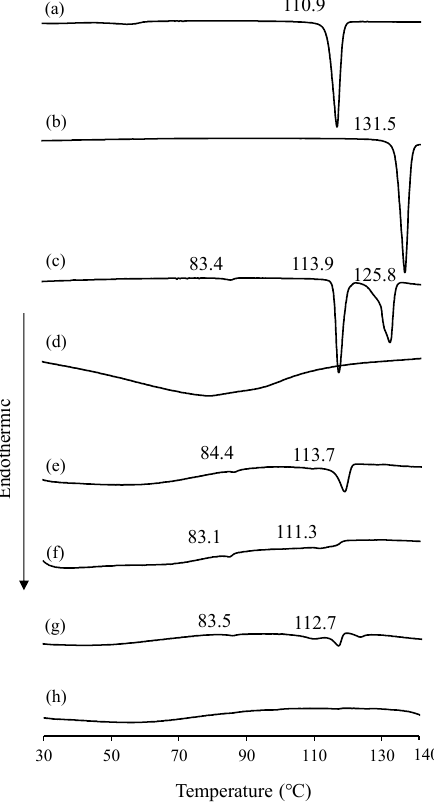
Figure 3. DSC curves of AU (ASCP/UR = 1/12)/ γ CD systems. ( a ) ASCP intact, ( b ) UR intact, ( c ) EVP AU (ASCP/UR = 1/12), ( d ) γ CD intact, ( e ) PM (AU (ASCP/UR = 1/12)/ γ CD = 1/1), ( f ) PM (AU (ASCP/UR = 1/12)/ γ CD = 1/2), ( g ) GM (AU (ASCP/UR = 1/12)/ γ CD = 1/1), ( h ) GM (AU (ASCP/UR = 1/12)/ γ CD = 1/2).